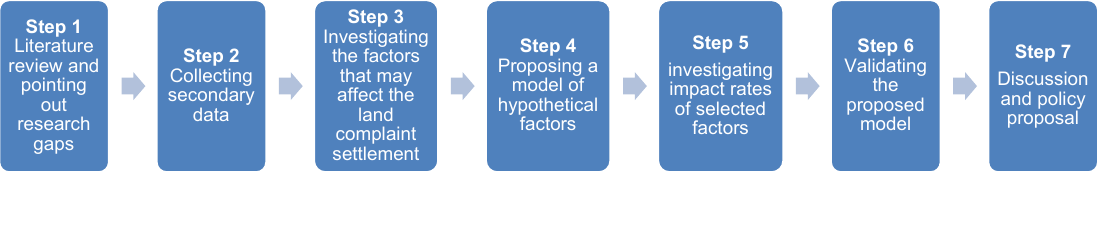
Fig. 2. The order of steps to study the factors that affect land complaint